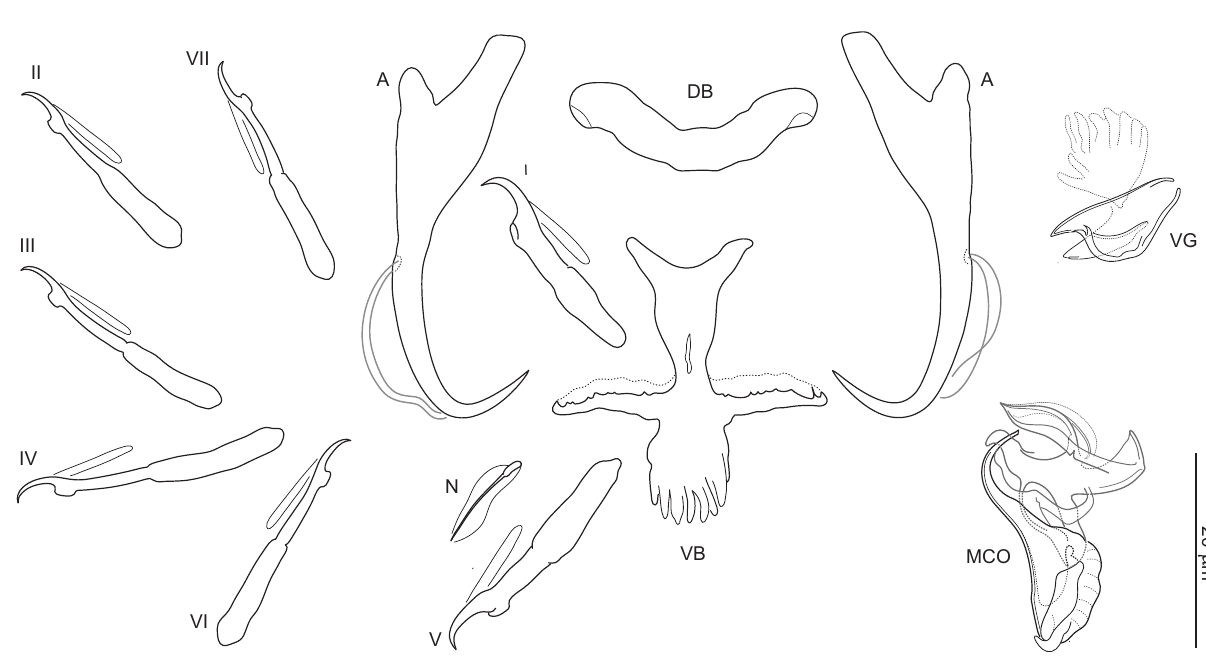
Figure 8. Sclerotized structures of Dactylogyrus recisus n. sp. ex Pachychilon macedonicum . A, anchor; DB, dorsal bar; VB, ventral bar; N, needle; I – VII, hooks; VG, vagina; MCO, male copulatory